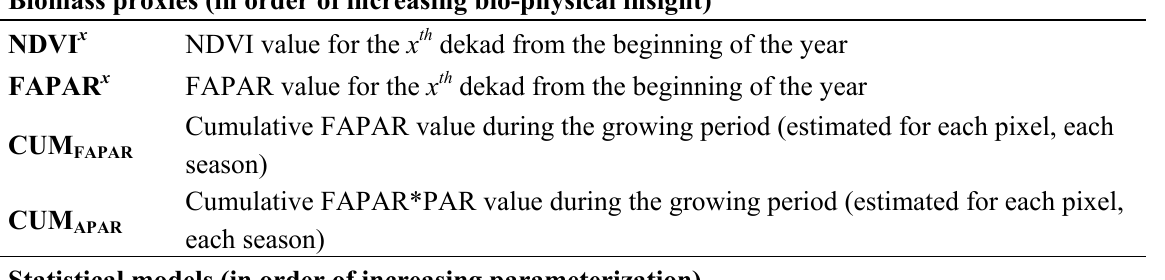
Table A1. Summary table of biomass proxies and statistical